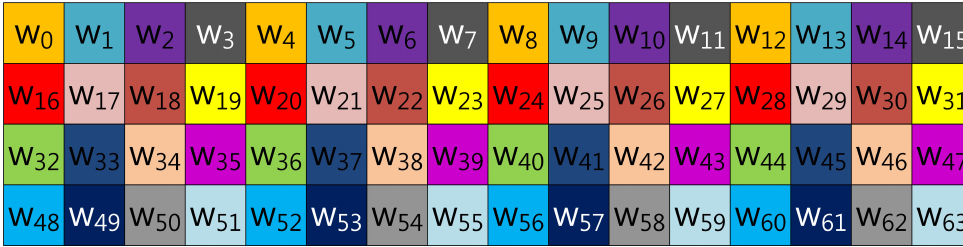
Figure 4. Look-up table structure of the proposed method in a block form for